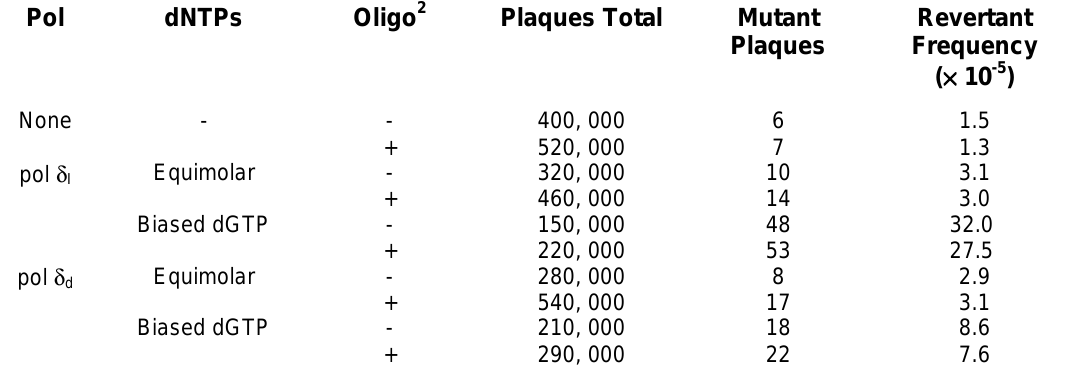
c Replication reactions were carried out for 2 h at 37ºC by using 50 ng gapped circular M13mp2T90 (sign – in oligo column), or for 10 min at 37ºC when a 26 mer oligonucleotide was hybridized in addition to the gapped circular M13mp2T90 DNA (sign + in oligo column). Other conditions were as in Table